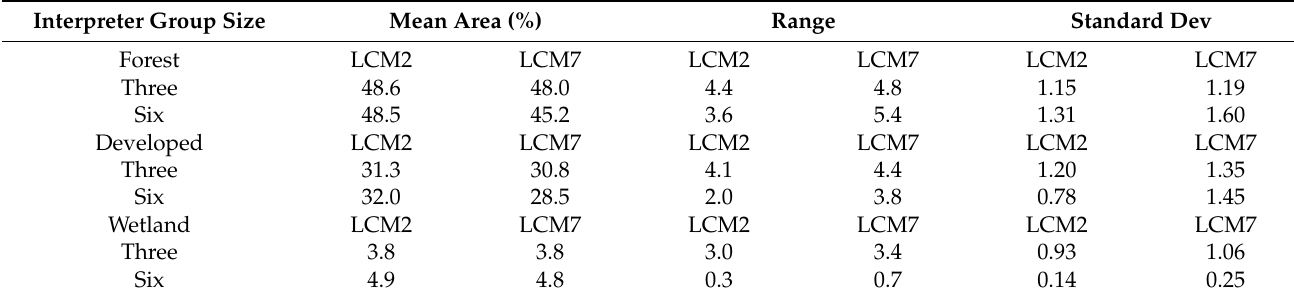
Table 7. Comparison of LCM area estimates produced from models with all seven land cover classes included in the manifest variables (LCM7) and estimates from models with a binary classification (LCM2) for three and six interpreter group sizes (2010 land cover